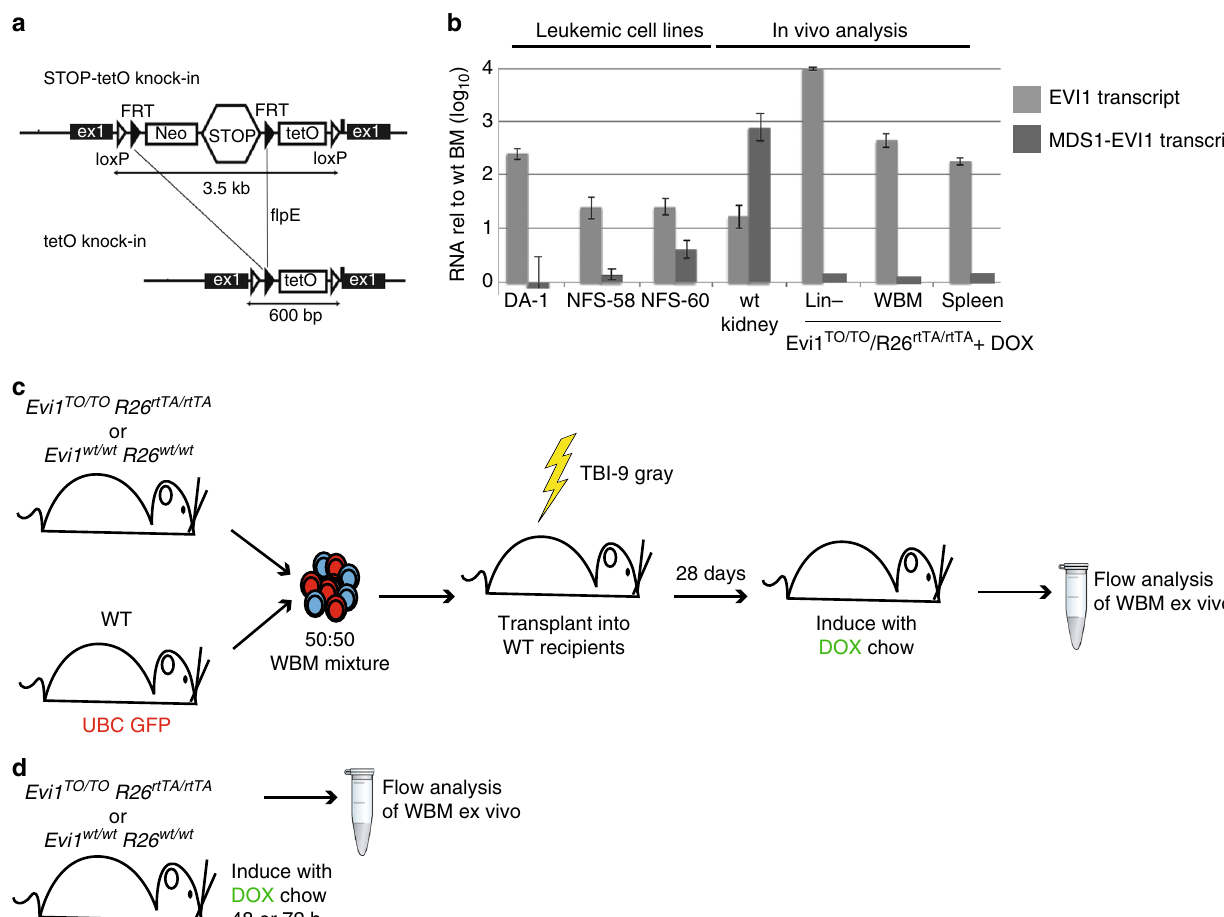
Fig. 1 Evi1 TO mouse model for 3q26-rearranged myeloid malignancies. a Schematic diagram of the Neo-Stop-Tet Operon (NSTO) construct from Tanaka et al. 63 that was inserted into the endogenous Evi1 locus by homologous recombination. The construct consists of a neomycin resistance gene and transcriptional Stop cassette fl anked by FRT sites, followed by seven Tet operons in succession and a minimal CMV promoter. Following homologous recombination in embryonic stem cells, the Neo-STOP cassette was removed by induction of fl pE recombinase. Black triangles represent FRT sites, and white triangles represent loxP sites. b Reverse transcription-quantitative polymerase chain reaction (RT-qPCR) analysis of RNA from cultured leukemic cell lines bearing a provirally-activated EVI1 allele (left-hand columns), or RNA from mouse tissues from wild-type (kidney, an organ with relatively high